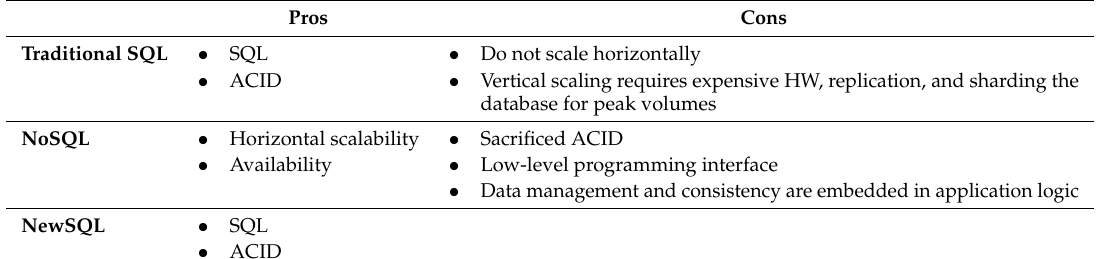
Table 1. Traditional SQL vs. NoSQL vs. NewSQL database management systems